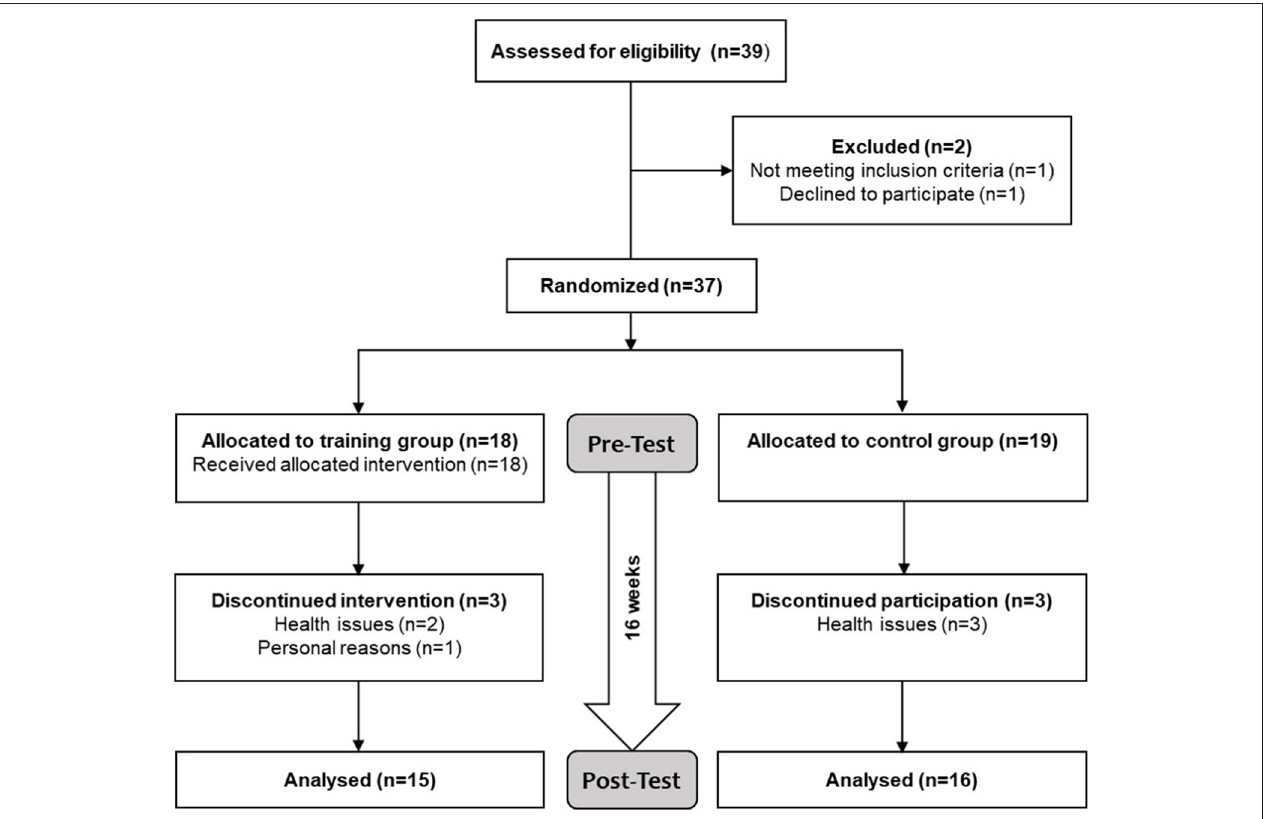
FIGURE 2 | Study flow chart. Screening for eligibility included a health questionnaire and the Mini Mental Status Examination. Eligible participants were randomly assigned to either training or control group. The participants of the training group trained 3x/week à 30–40min for 16 weeks while the participants of the control group continued with their normal daily living. Physical and cognitive functions as well as brain volume were assessed before and after the intervention